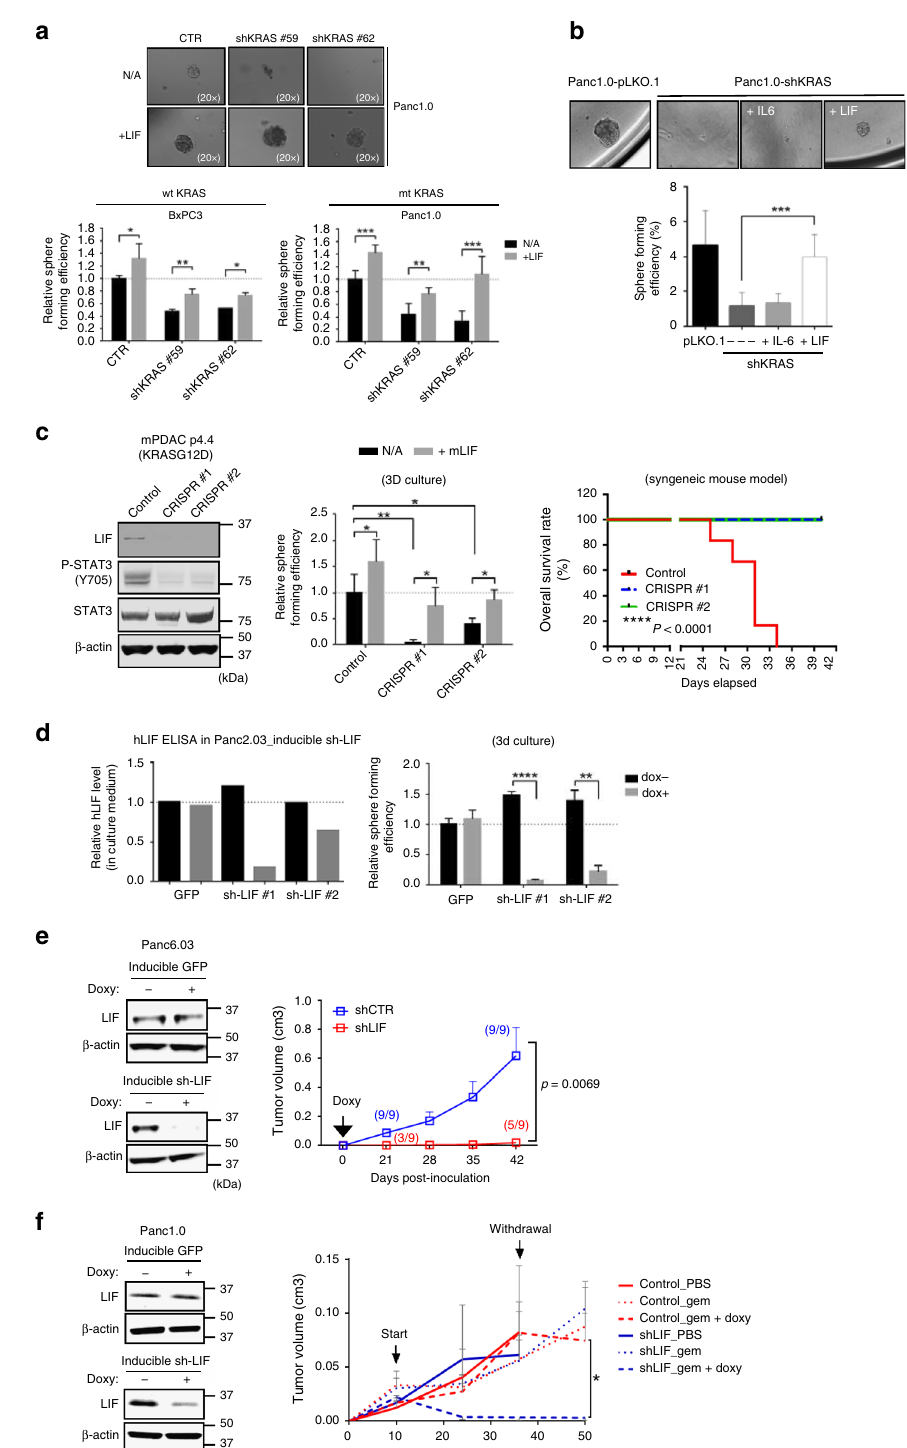
factor (CNTF), and cardiotrophin-1 (CT-1). LIF initiates cell signaling through formation of heterodimer with speci fi c LIFR and the common co-receptor for IL-6 family (gp130). Signal transduction of IL-6 family members is highly similar and dominated by STAT3 activation. Aberrant/unrestrained STAT3 activity is detected in a wide variety of tumors, including pan- creatic and lung adenocarcinomas 4 . Thus, STAT3 has been widely considered as an oncogene and is the object of intense translational studies. Yet, none of the anti-STAT3 agents, ranging NATURE COMMUNICATIONS| (2019) 10:3055